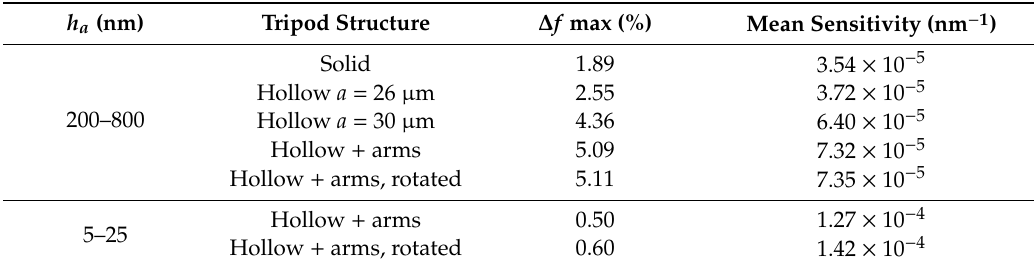
Figure 4. Reflection coefficient for different analyte thicknesses for the hollow tripod structure with arms ( a ), and the hollow tripod structure with arms, and rotated ( b ). Insets: zoom of the reflection coefficient for both metastructures and extremely thin film analytes (0–25 nm). Frequency shift as a function of the analyte thickness, with average sensitivity for the hollow tripod structure with arms ( c ), and the hollow tripod structure with arms, and rotated ( d ). Table 1. Comparison of the most relevant quality parameters of the three tripod-metastructures studied in this work when working as thin-film sensors where the analyte thickness deposited varies between 200 and 800 nm (top), and for ultra ‐ thin analytes between 5 and 25 nm (bottom).